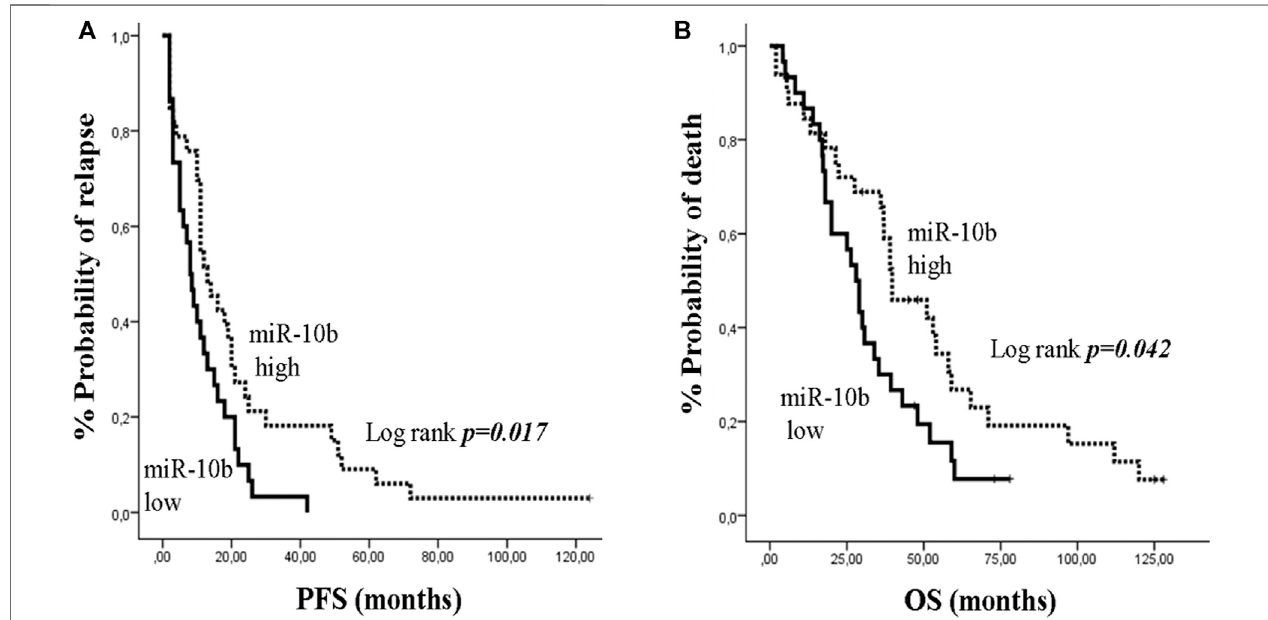
FIGURE 5 | Kaplan – Meier analysis for progression free survival (PFS) and overall survival (OS) according to the expression of circulating miR-10b in metastatic breastcancerpatients.Patients wereclassi fi edashighorlowexpressiongroupsbasedonthemedian valueofmiR-10bexpression. (A) PFSand (B) OSinpatientswith high or low miR-10b. Curves were compared using the log rank test. P values are